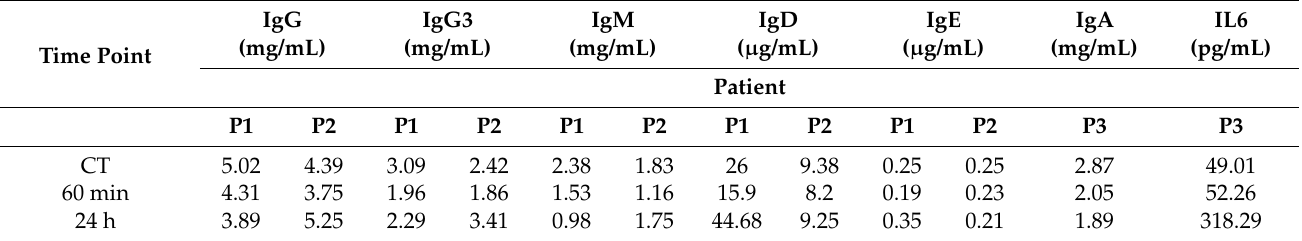
Figure 1. Serum IL-6 concentration (median ± quartile deviation; 25th and 75th percentiles). ( A ) Comparison based on the age of patients: 19–46 years and 73–80 years. ( B ) Comparison based on the sex of the patients. CT: measurement before the onset of CPB; 60 min: measurement at 60 min of the CPB onset; 24 h: measurement at 24 h after the onset of CPB. Values with different letters (a, b) indicate significant differences within the age or sex category (Friedman’s test or Mann–Whitney U test; p < 0.05). Table 3. Concentrations of immunoglobulins and IL6 in sera of patients with a diagnosed postopera- tive infection: P1 (men), P2, and P3